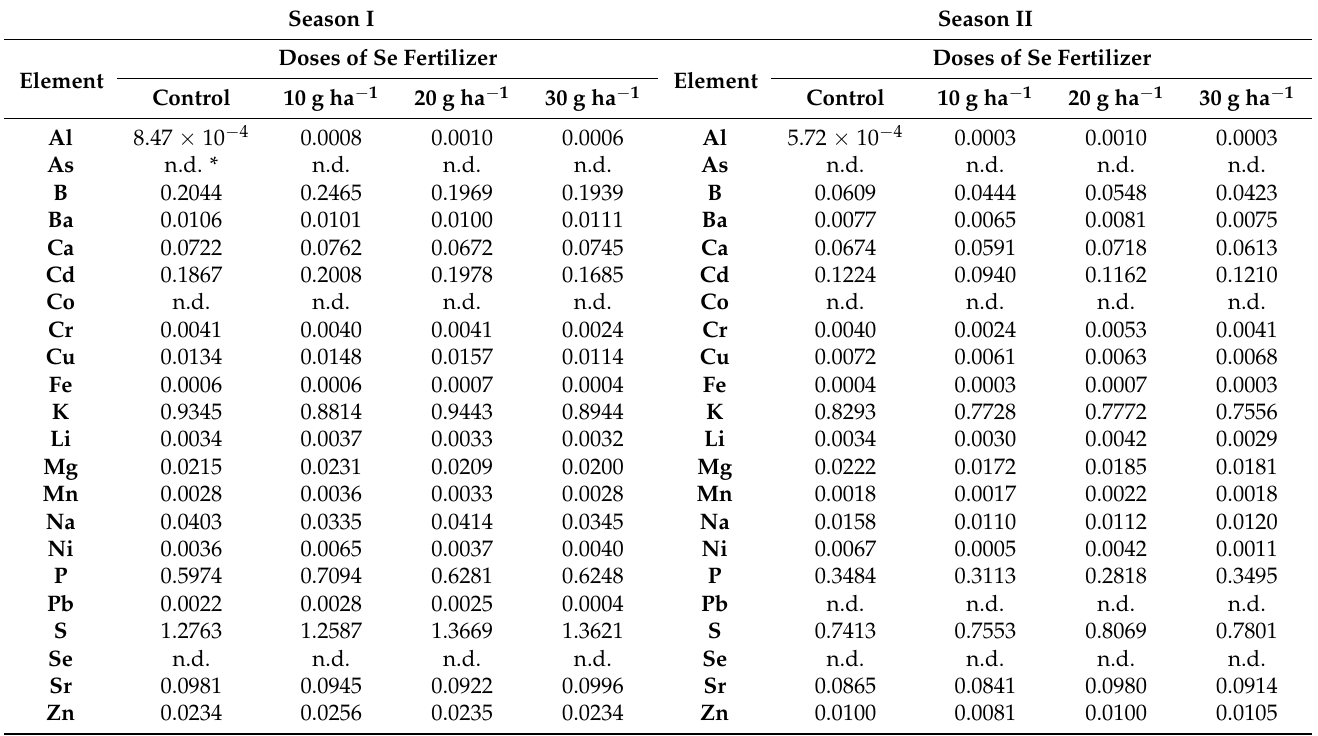
Table 5. Bioaccumulation factor (BAF) values for biogenic elements in the leaves of A. schoenoprasum for both